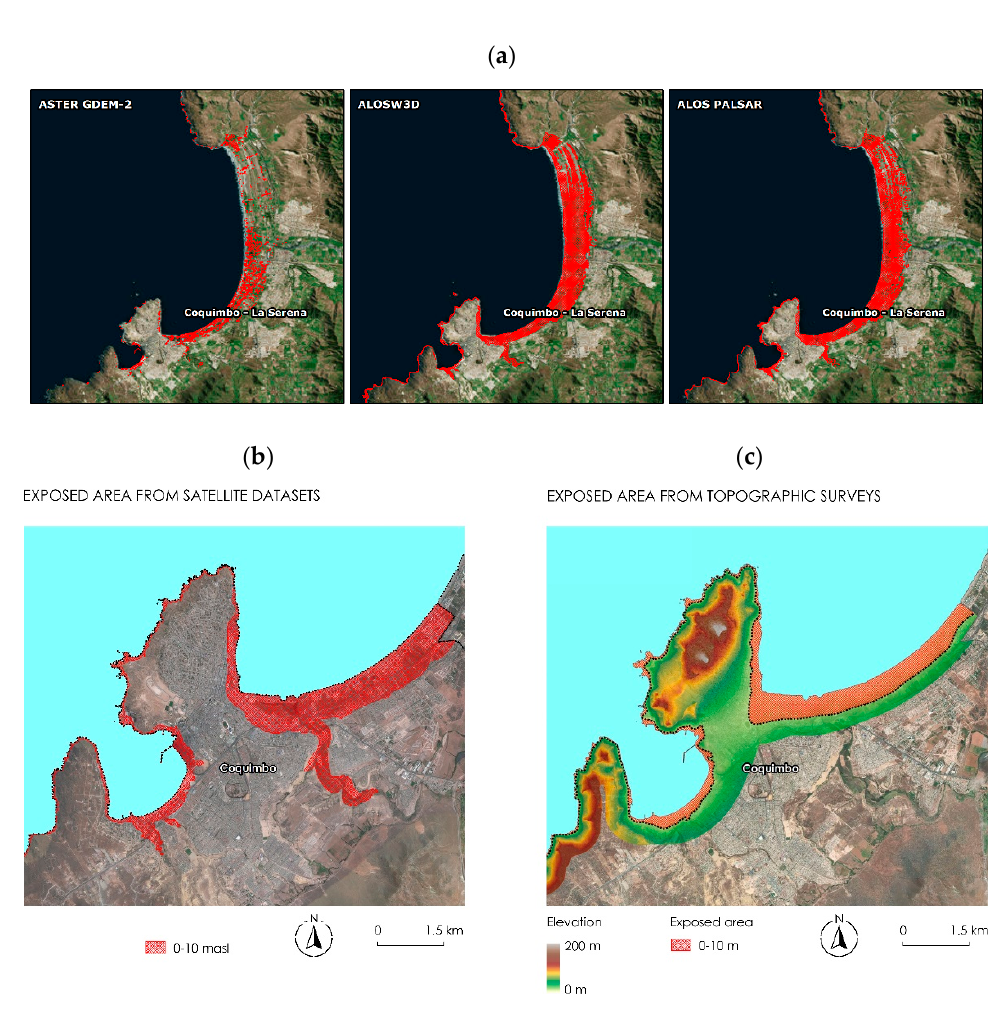
Figure 3. ( a ) Selection of pixels below masl from the three satellite datasets at Coquimbo Bay (29.959° S–71.334° W). ( b ) Polygon of exposed area generated from satellite data. ( c ) Polygon of exposed area generated from topographic surveys.